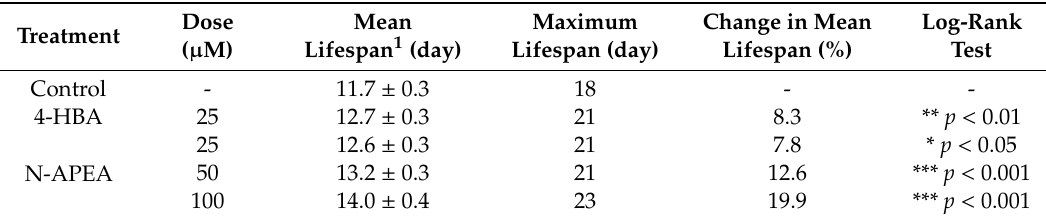
Figure 4. Longevity effects of N-APEA in wild-type N2 C. elegans at 25, 50, and 100 μ M. ( a ) The mortality of each group was determined daily by counting the dead worms. ( b ) The mean lifespan of the nematodes was evaluated based on the survival curves in (a). The bar graph represents the mean ± SEM of three independent experiments, and each group in the experiment consisted of 50 worms. Significance was determined by one-way ANOVA (* p < 0.05, ** p < 0.01, and *** p < 0.001). 4-HBA (4-hydroxybenzoic acid) was used as a positive control. Table 2. Effects of N-APEA on the lifespan of C. elegans.